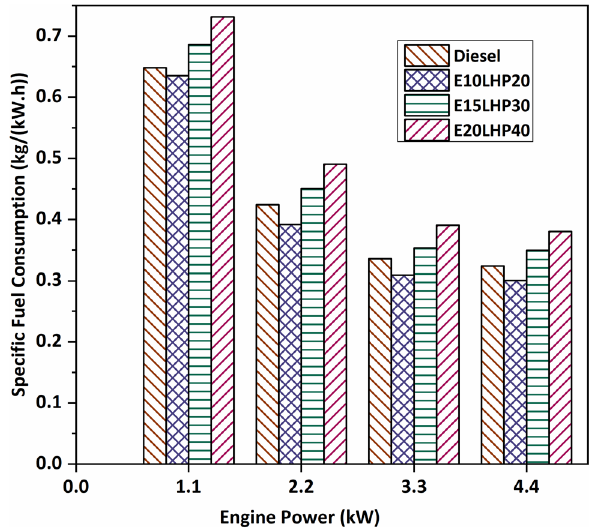
Figure 3. Impact of specific fuel consumption on LHP and ethanol blends.